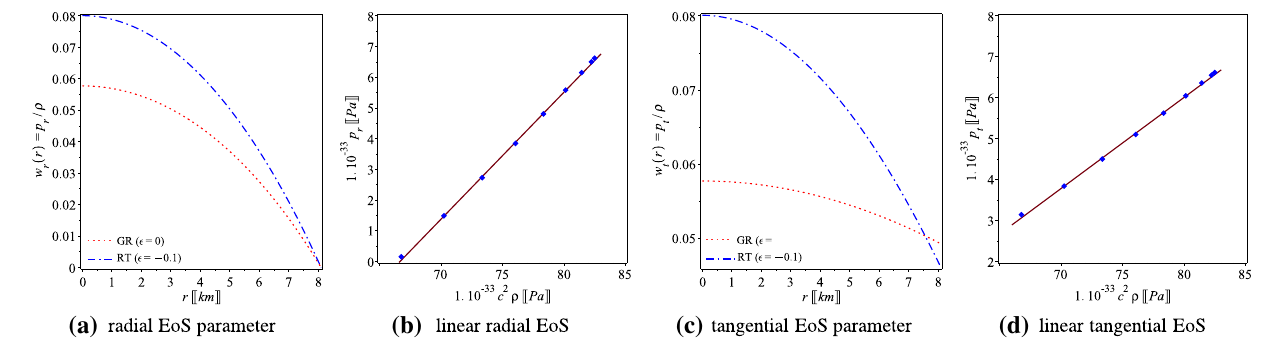
at any stage of the present work, while it is evidently that the result fit well with the linear behaviour whereas the best fit lines in b and d are